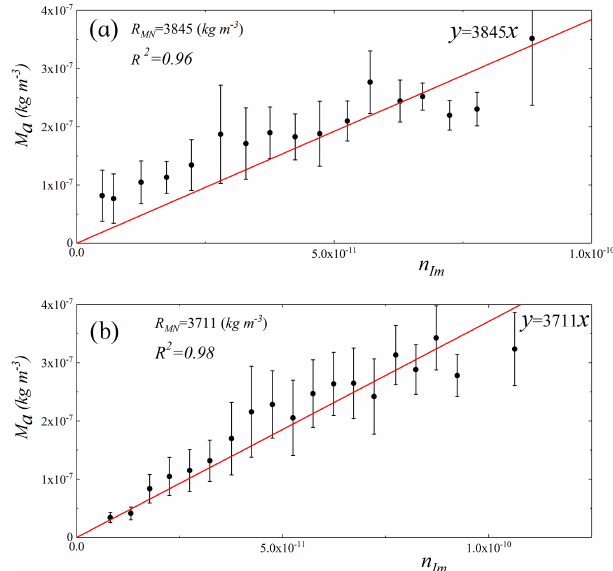
Figure 2. Relationship plot of aerosol mass concentration M a and the imaginary part of the AERI for (a) the Beijing area and (b) the Baoding